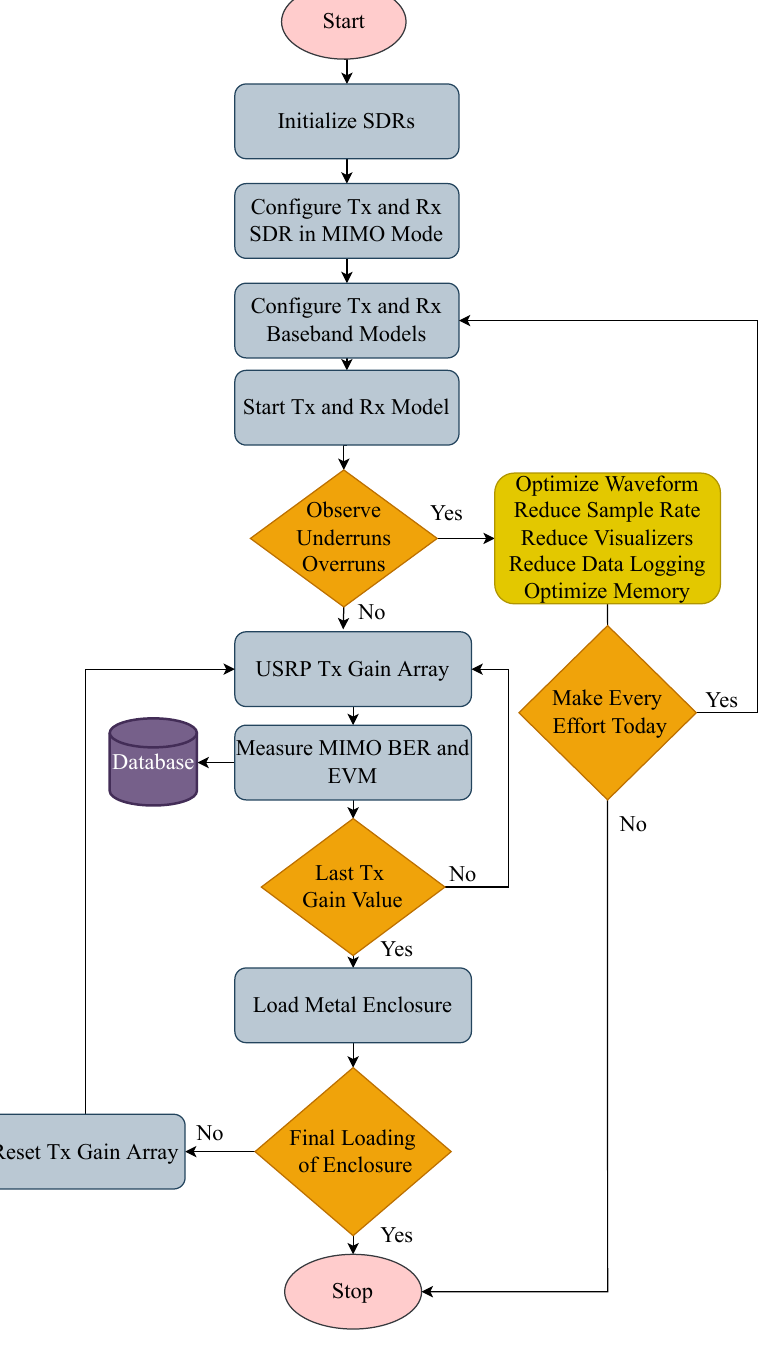
Figure 3. Flowchart of MIMO BER and EVM